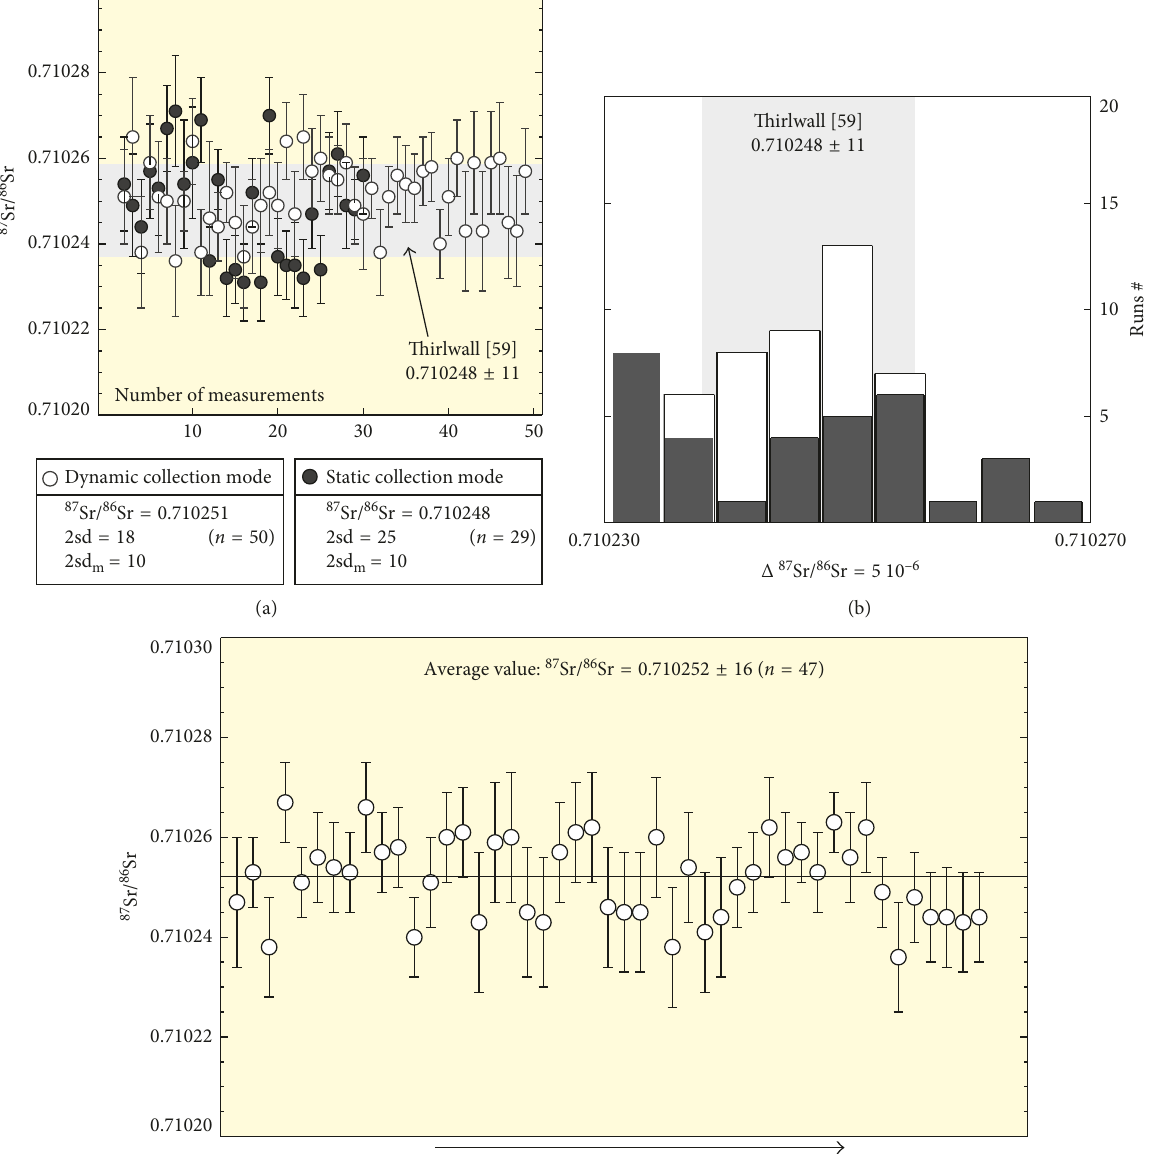
Figure 6: (a) Reproducibility and accuracy for repeated measurements of 87 Sr/ 86 Sr on 12 ng load size of NSIT-SRM987 standard material for static versus dynamic collection mode over a period of 10 months. Each single measurement is plotted with the relative error bars. The grey- shaded field shows the [59] recommended value range. (b) Distribution of the 87 Sr/ 86 Sr values measured all over the period of analysis with the static and dynamic collection mode: the static collection mode (black filled columns) shows a worst external reproducibility than that obtained in the dynamic mode (open columns); indeed the dynamic mode gives measurements that reasonably fit a Gaussian distribution pattern with the more representative 87 Sr/ 86 Sr values centered within the [59] recommended interval (grey shade fields); (c) reproducibility and accuracy trend of 87 Sr/ 86 Sr 12ng load size of NSIT-SRM987 measured in the dynamic collection mode throughout the setup period (from 2014 to